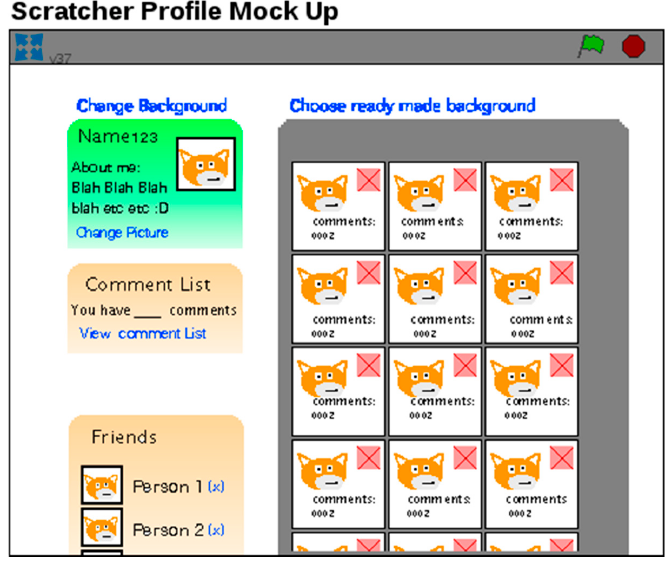
Figure 6. Scratch project showing a mock-up of a proposed Scratch member page.